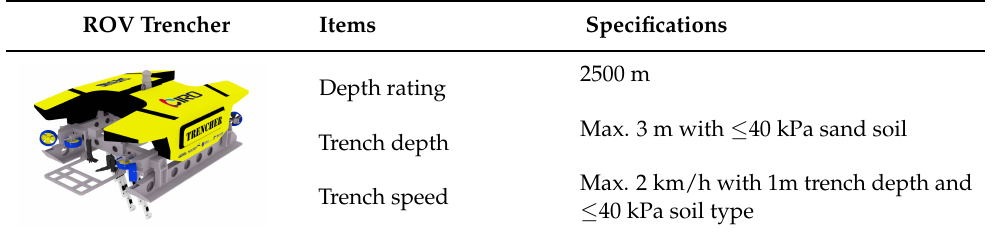
Table 1. ROV trencher required